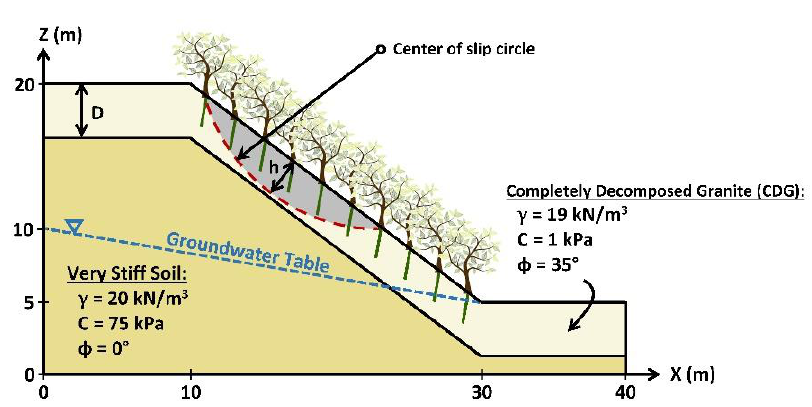
Figure 16. Schematic profile of slope used in example 5 [60]. Table 9. Root properties for modeling of soil–root interactions [60].